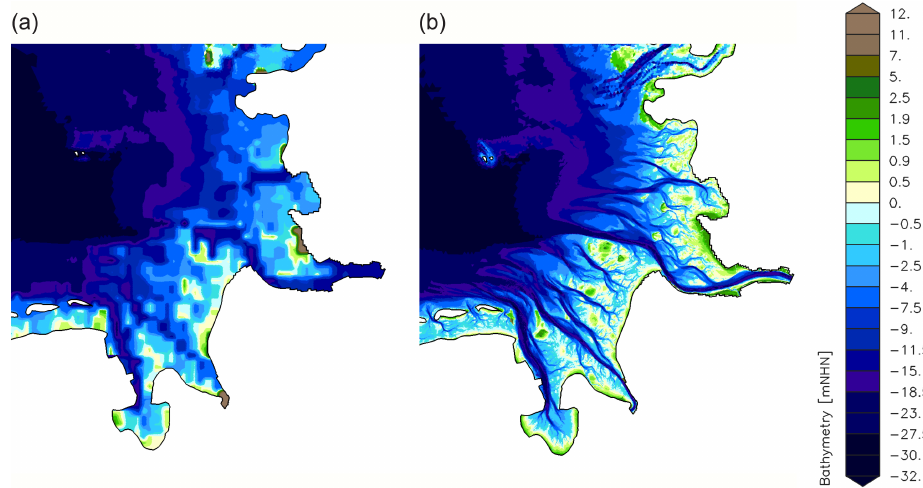
Figure 5. Bathymetry in the German Bight, (a) coarse model bathymetry on the high-resolution grid, (b) the original highly resolved bathymetry of the